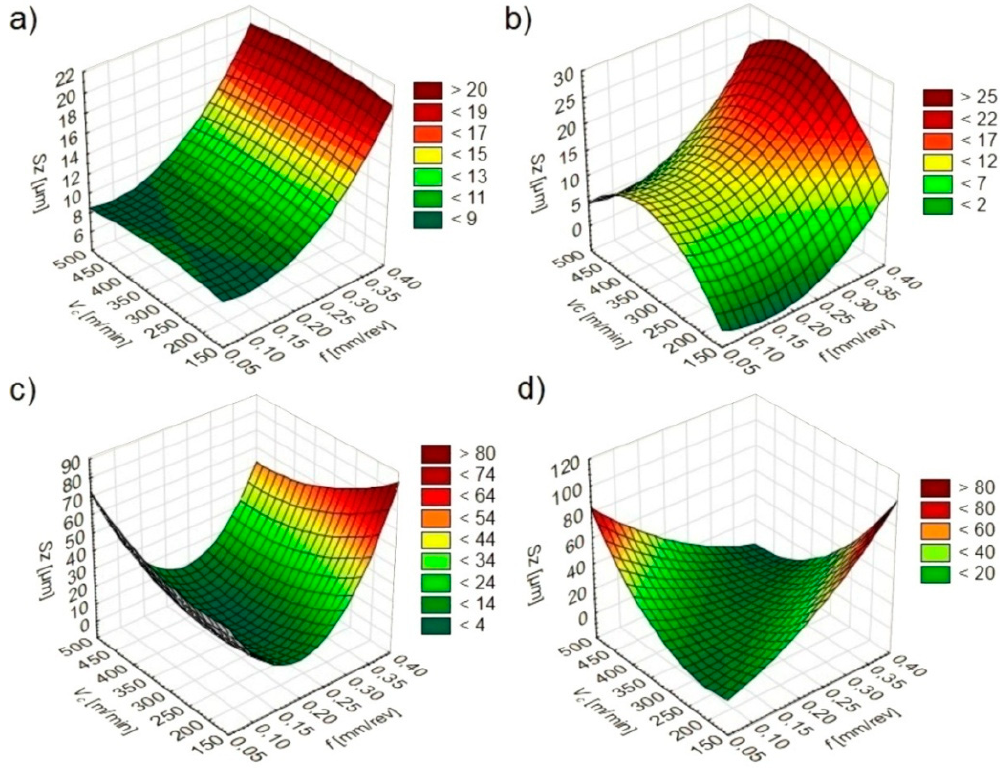
Figure 4. Sz dependence on cutting parameters under: ( a ) dry; ( b ) wet; ( c ) MQL; ( d ) MQL+EP conditions.